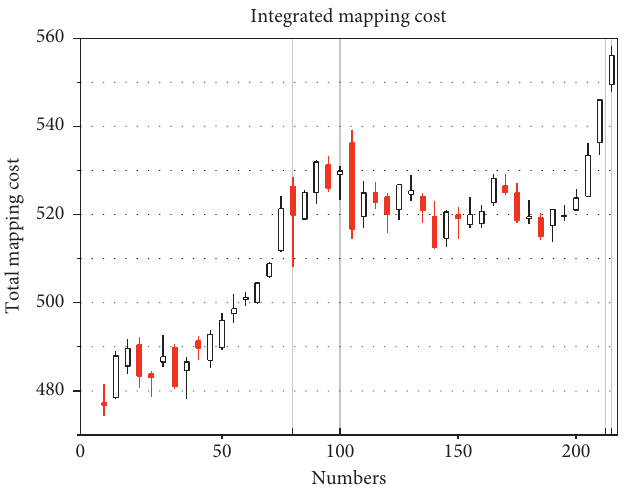
Figure 7: Integrated mapping cost.